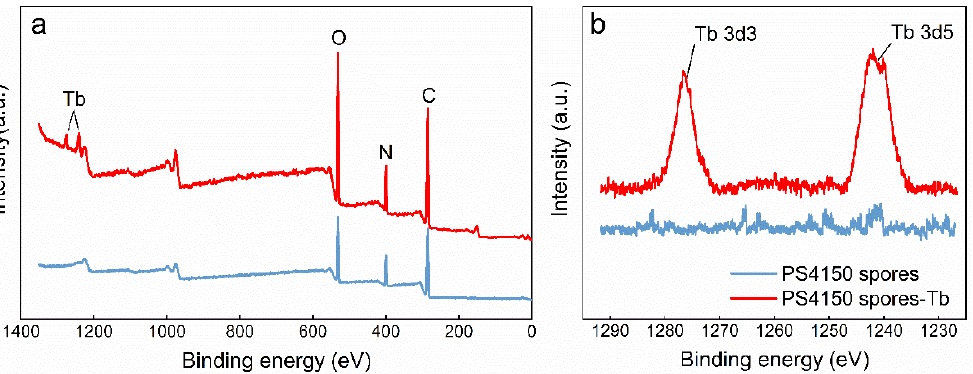
Figure 6. XPS spectrum of spores before and after adsorption of Tb(III): ( a ) survey scanning spectra; ( b ) Tb 3d spectra of Tb − spores.